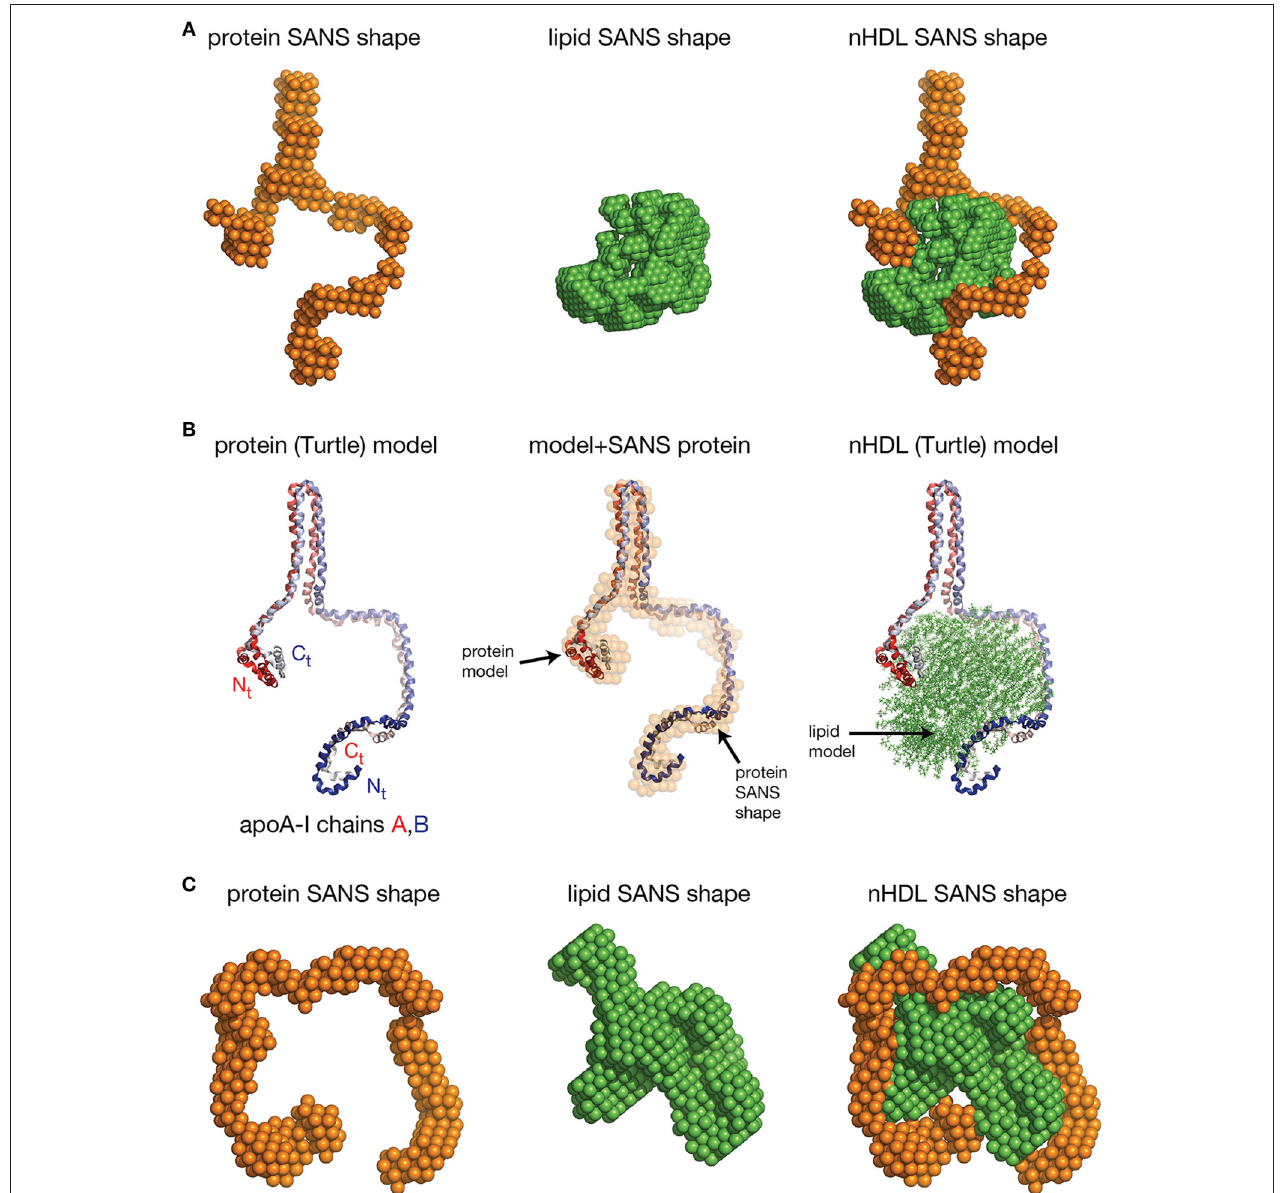
FIGURE 6 | The low resolution structures nHDL reconstituted with DMPC and with DMPC/FC. (A) Left: The low resolution structure of the protein component of nHDL reconstituted with DMPC. Middle: The low resolution structure of the lipid component of nHDL reconstituted with DMPC. Right: The low resolution structure of nHDL reconstituted with DMPC as a combination of the low resolution structures of the protein and lipid components of nHDL. (B) Left: the Y-shaped full length apoA-I dimer in nHDL reconstituted with DMPC proposed by Gogonea et al. (2013). The apoA-I chains shown in cartoon representation and colored with gradient red/blue, are oriented antiparallel in helix 5 registry. Middle: Superposition of the apoA-I double chain with the low resolution structure of the protein component of nHDL reconstituted with DMPC obtained by SANS with contrast variation. Right: The Turtle model of nHDL reconstituted with DMPC; the lipid model was built from 160 DMPC molecules in a combined micellar/lamellar phase. The majority of lipids follow a lamellar arrangement while few of them are arranged radially (as in a micelle) to accommodate the open conformation of apoA-I. (C) Left: The low resolution structure of the protein component of nHDL reconstituted with DMPC and FC. The SANS shape resembles a horseshoe. Middle: The low resolution structure of the lipid component of nHDL reconstituted with DMPC and FC. Right: The low resolution structure of nHDL reconstituted with DMPC and FC as a composite of the low resolution structures of the protein and lipid components of nHDL reconstituted with DMPC and FC. The low resolution structures of the protein and lipid components fit each other like a “key in a